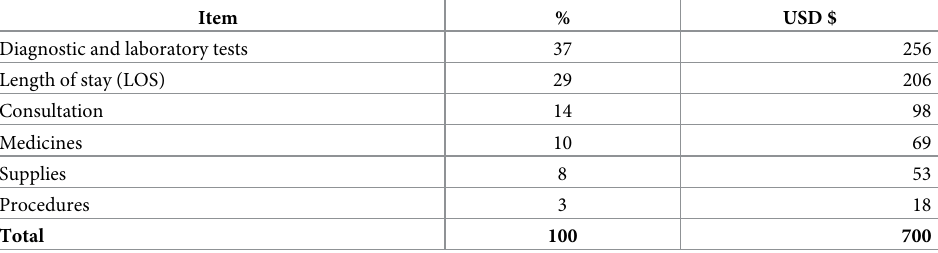
Table 3. Direct medical costs per patient and item for influenza SARI in